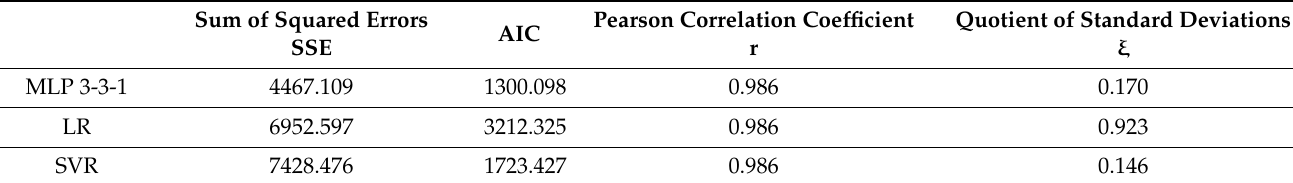
Table 3. Prediction results for LR and SVR models.